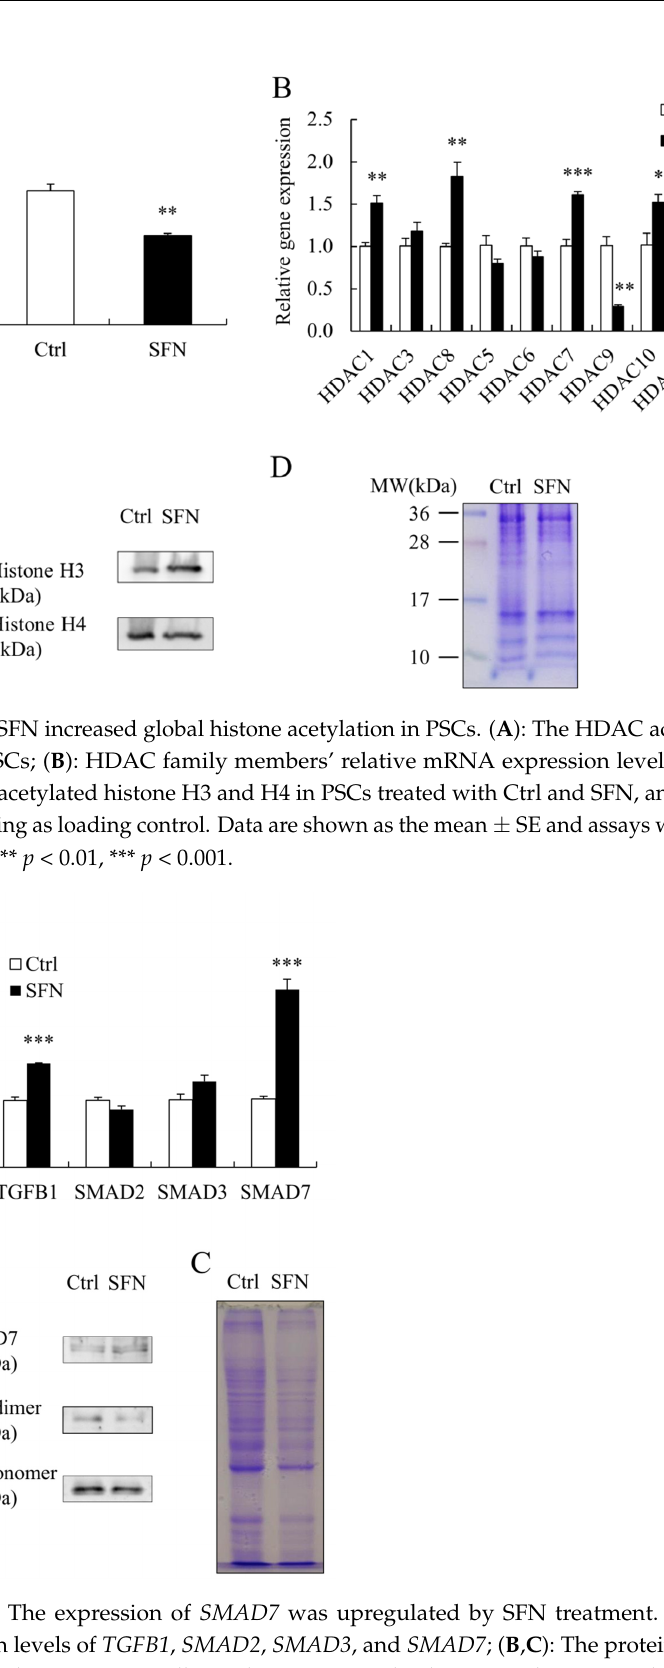
Figure 4. The expression of SMAD7 was upregulated by SFN treatment. ( A ): Relative mRNA expression levels of TGFB1 , SMAD2 , SMAD3 , and SMAD7 ; ( B ) and ( C ): The protein levels of TGFB1 and SMAD7 with Coomassie-Brilliant Blue staining as loading control. Data are shown as the mean ± SE and assays were done in triplicates. *** p < 0.001.